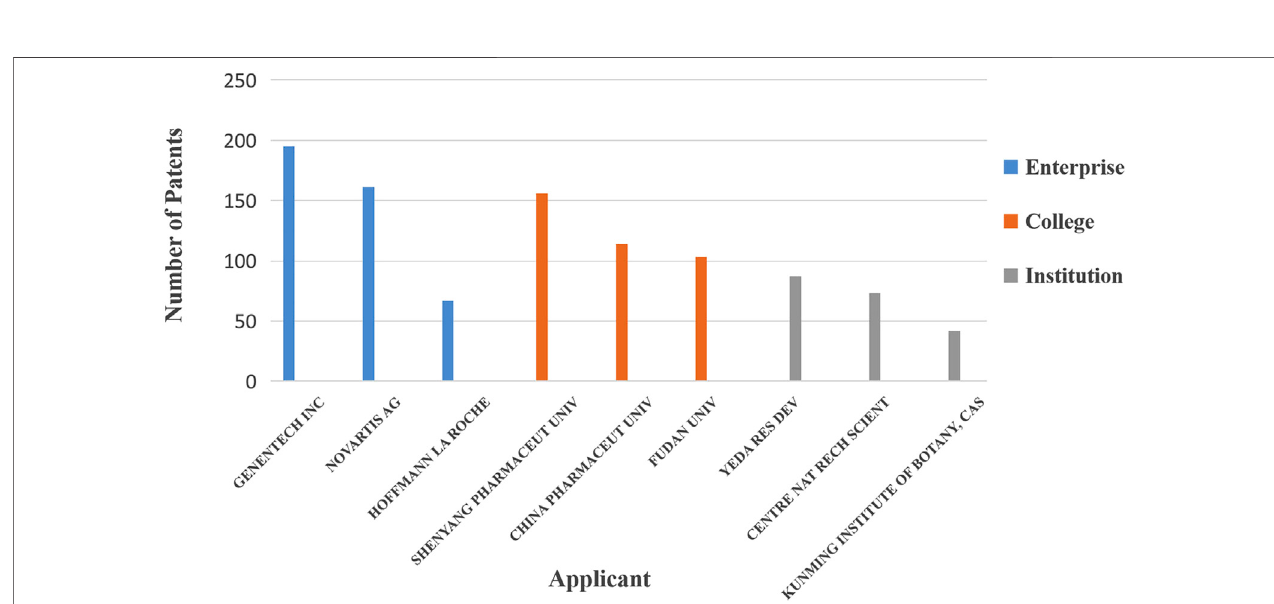
FIGURE5| Distributionofhigh-valuepatentsforanticancernaturalproductsbasedonthetypeofapplicant.Genentech,Inc.,hasaccumulatedthelargestnumber of patents in this fi eld.